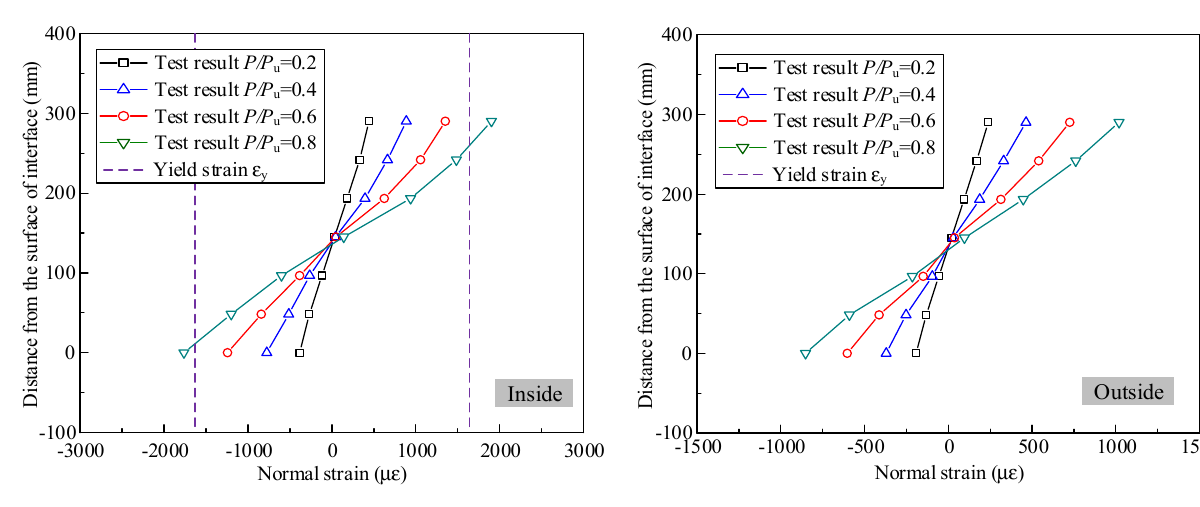
(b) 1/4-span section of CCB-1. Figure 13. Cont